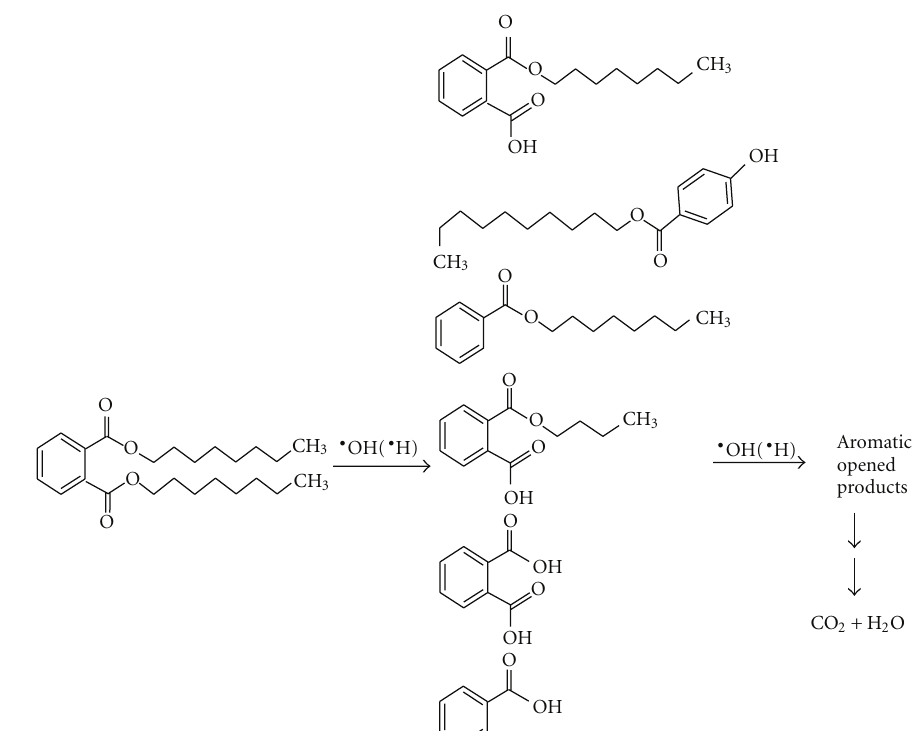
Figure 7: Photocatalytic degradation scheme for DEHP